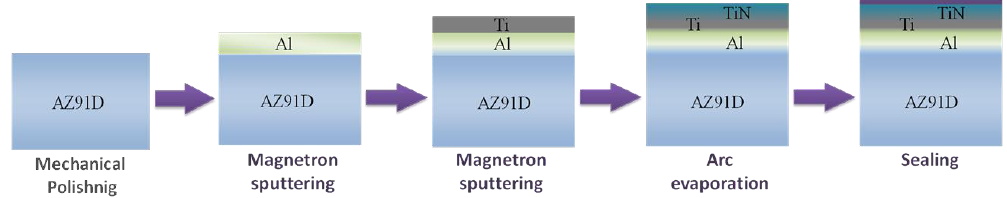
Figure 1. A schematic presentation of the experimental procedure of the hybrid process of producing composite titanium nitride TiN2Ti1Al10_SS layers with an intermediate titanium and aluminum sub-layer.